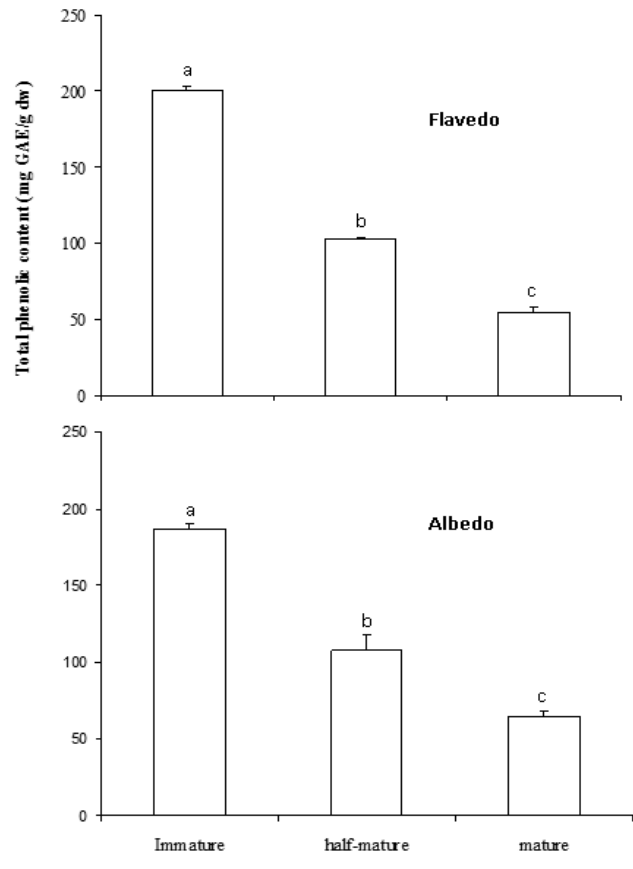
Fig. 2: Total phenolic contents (mg GAE /g extract) at different stages of maturity. Different letter(s) on bar indicate statistically significant differences ( p